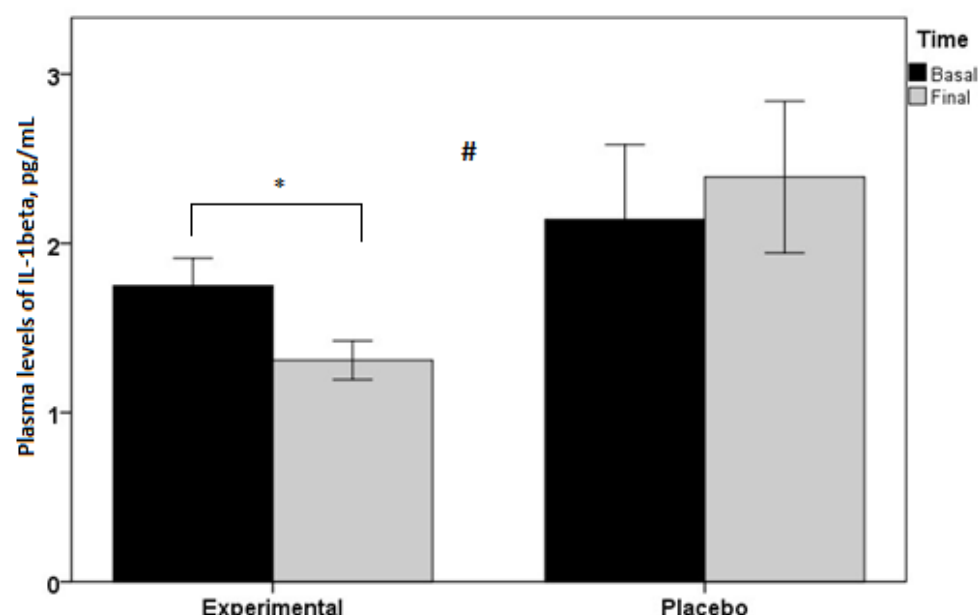
Figure 2. Changes in plasma levels of IL-1 β in the experimental (cucumber extract) and placebo groups at the final visit vs. baseline (bars = ±1 standard error); * p < 0.05; # p = 0.044.